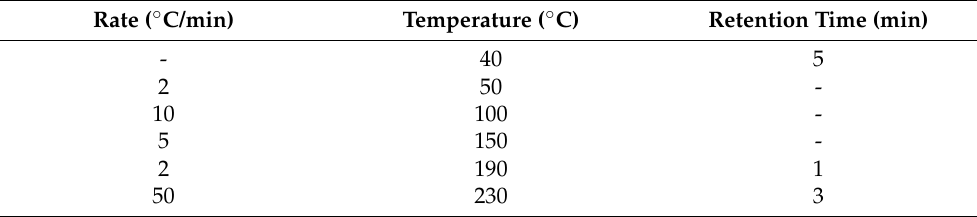
Table 2. For quantitative analysis, except that the split ratio was 50:1, the rest of the analysis conditions were the same as those of the qualitative analysis. Table 2. Column temperature program. Rate ( ◦ C/min) Temperature ( ◦ C) Retention Time (min) - 40 2